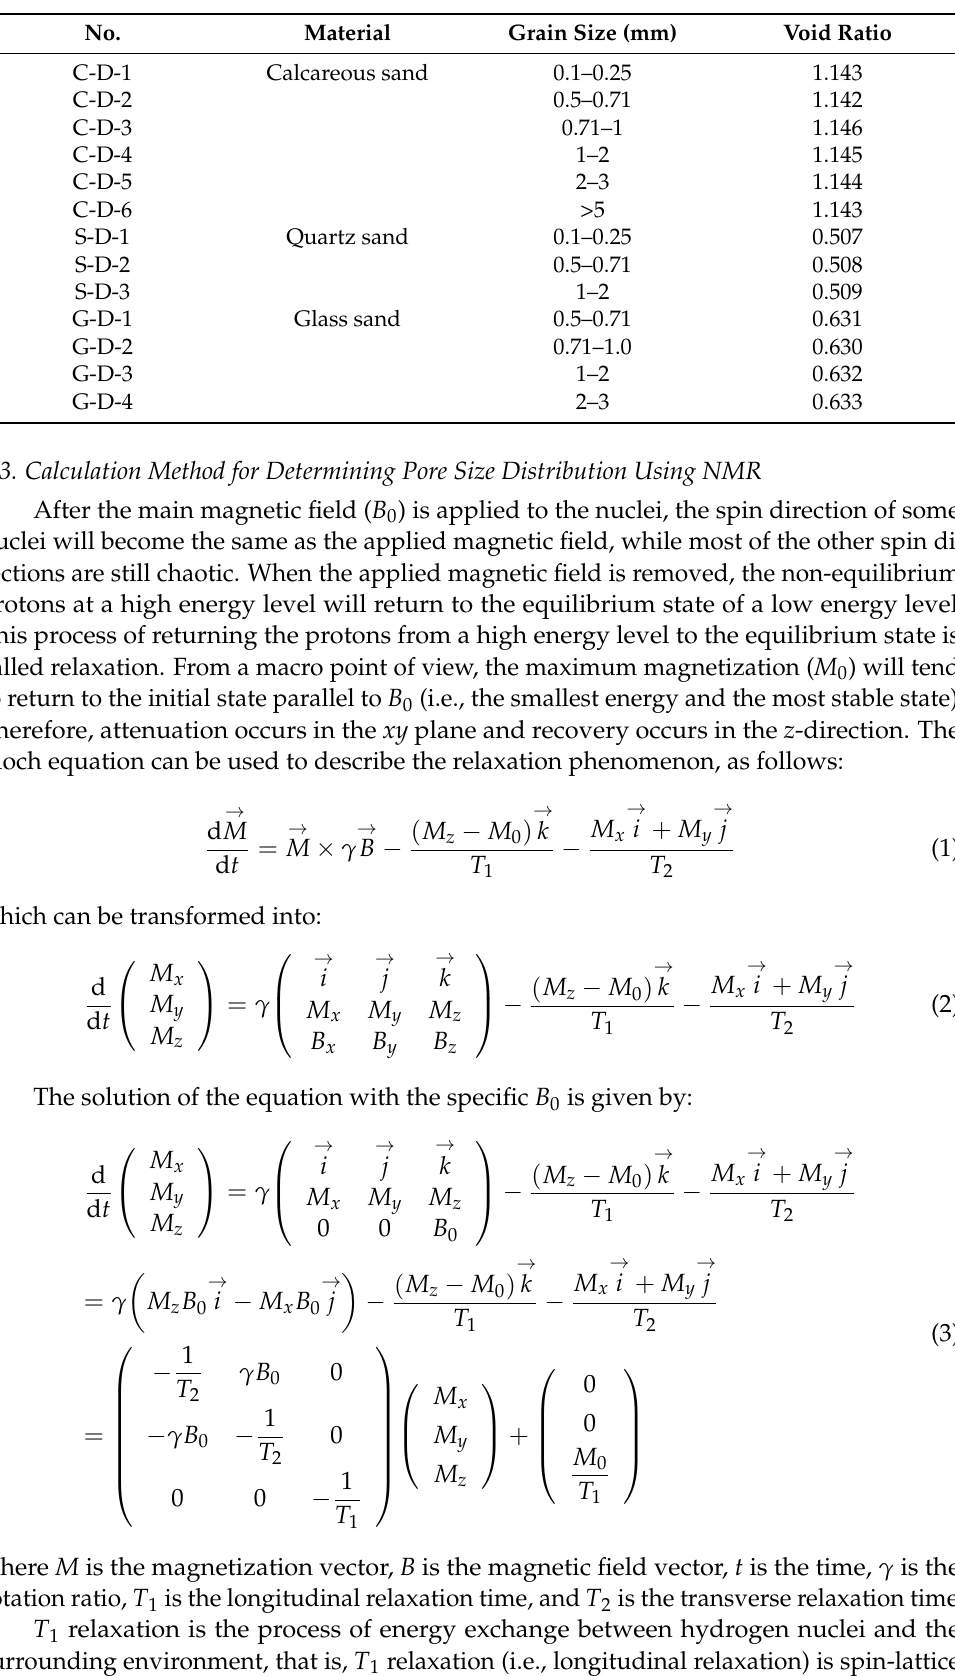
Table 1. Test program of this